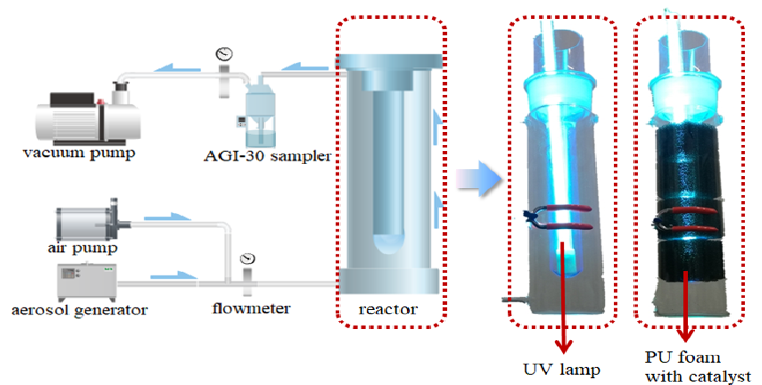
Figure 7. Polyurethane foam design for the inactivation of E. coli . Reprinted from [107], Copyright (2021), with permission from Elsevier.